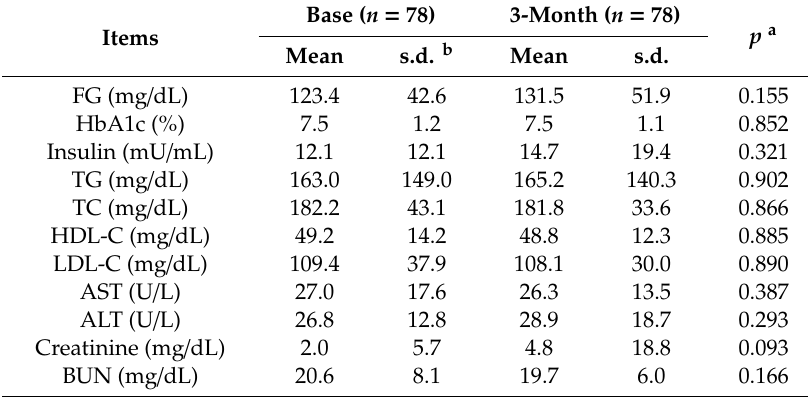
Table 2. Independent t -test of biochemical indices for the control